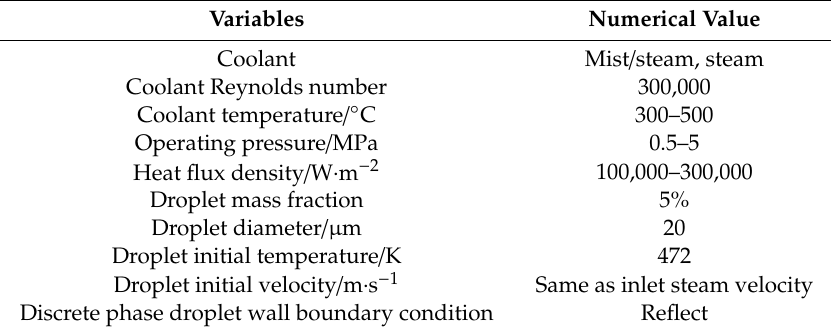
Table 1. Boundary conditions of numerical calculation for gas turbine under actual working conditions.